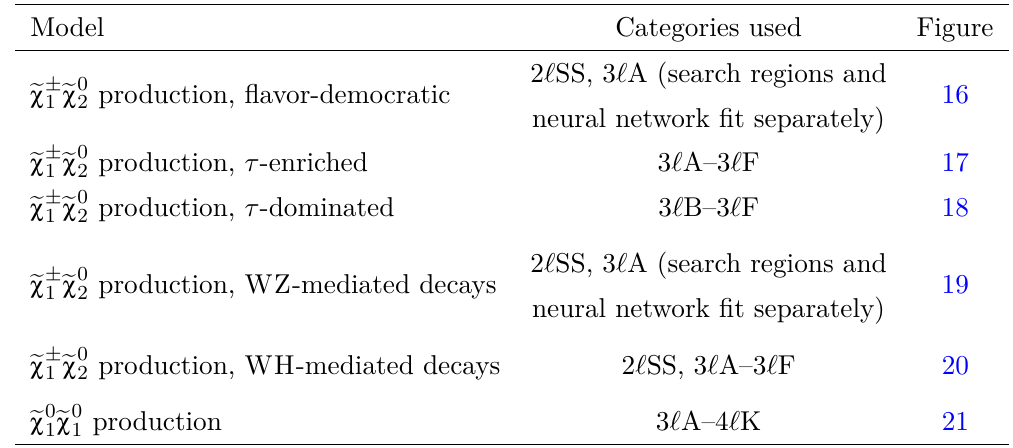
Table 13 . Summary of the event categories used for the interpretation of the results in terms of different models, and references to the associated figure summarizing the expected and observed 95% CL upper